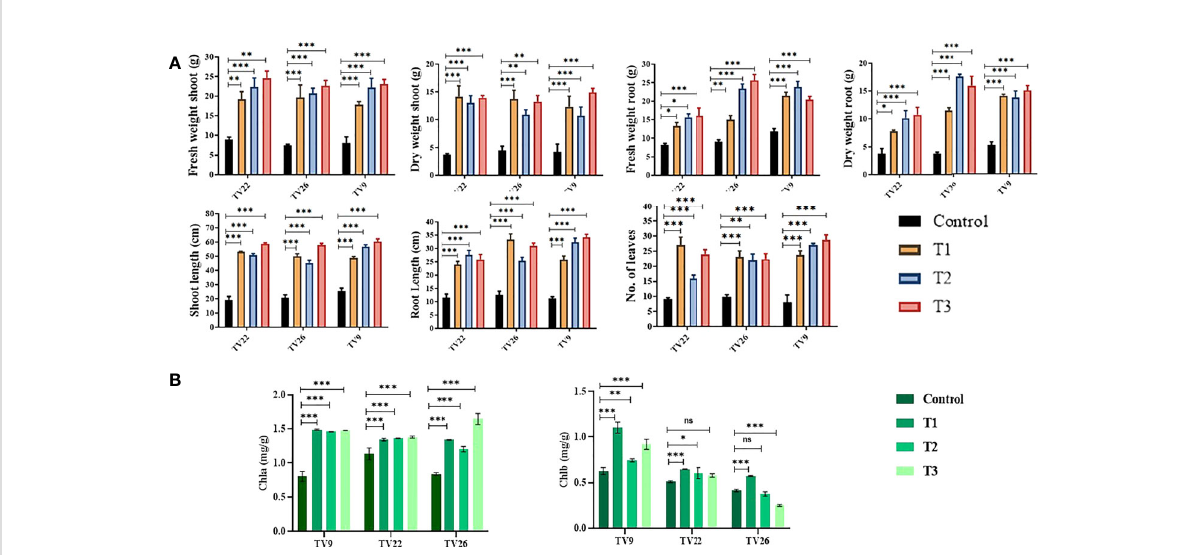
FIGURE 7 Evaluation of PGP experiment to show the effect of treatments of endophytic actinobacterial inoculum in tea clones TV22, TV26, and TV9. (A) vegetative parameters (B) chlorophyll (a, b) Error bar represents the standard error of means of replicates (*p < 0.05, **p < 0.01, ***p < 0.001). ns-not signi fi cant.